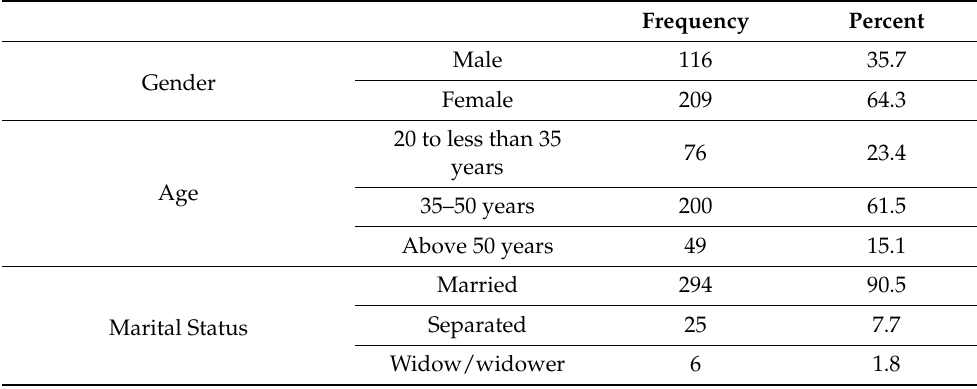
Table 1. Demographics of the